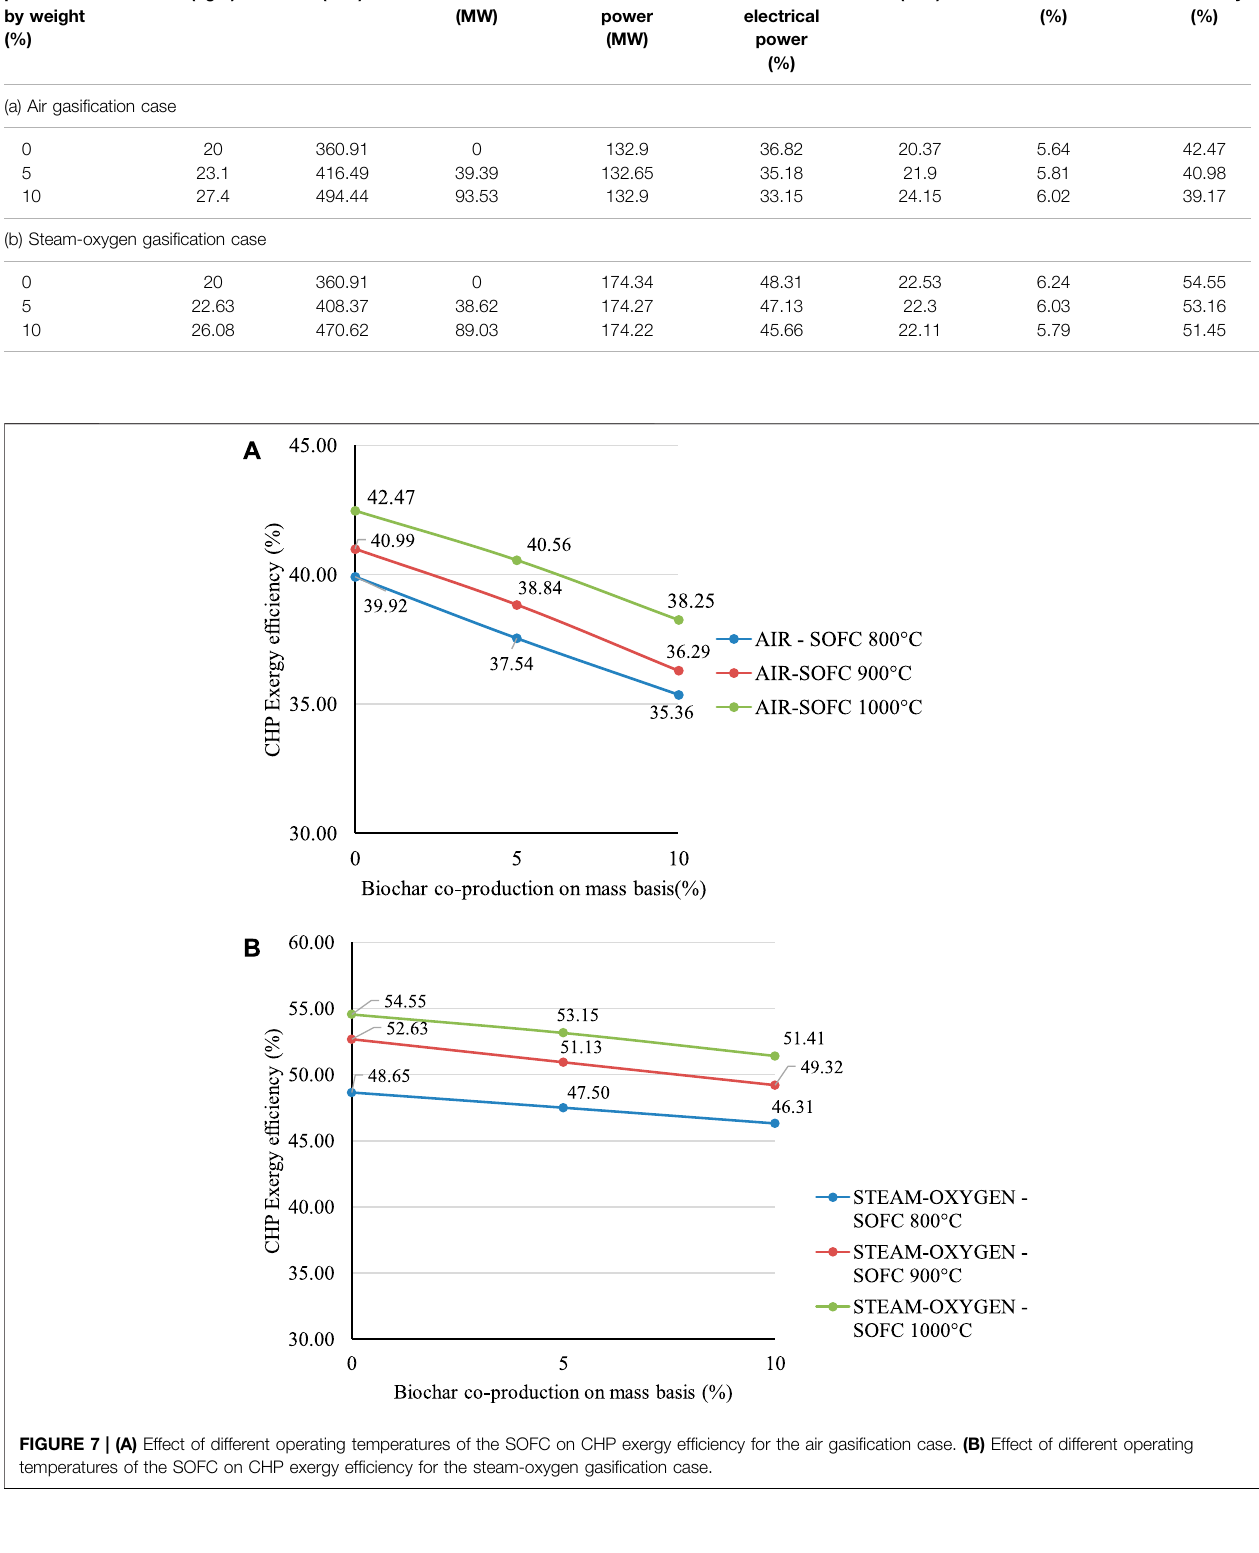
Frontiers in Energy Research |